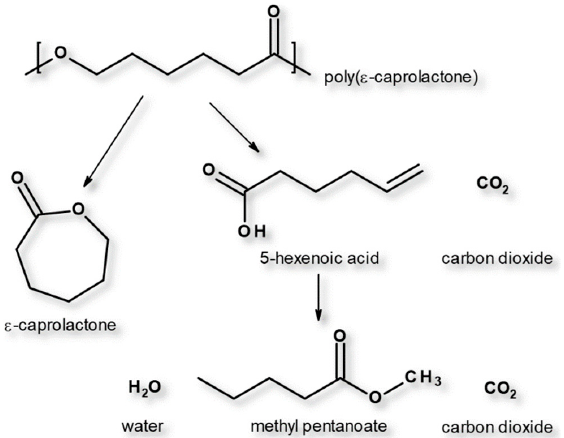
Figure 3. Three-dimensional image of TGA–FTIR analysis for PCL and PCL modified by DCP and BIB.